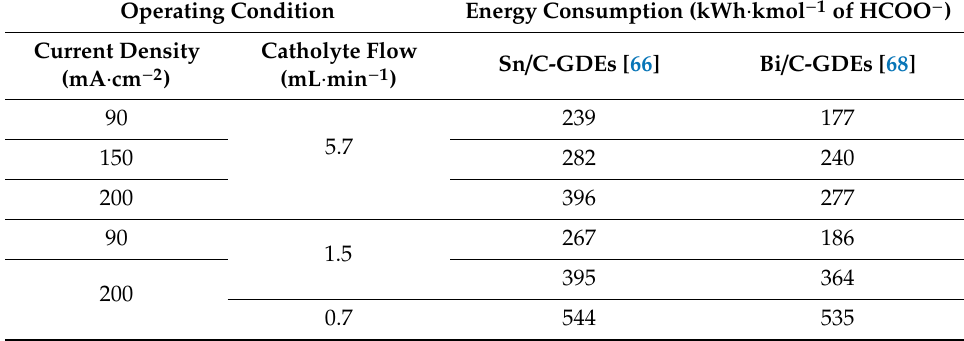
working with Sn / C-GDEs and Bi / C-GDEs at di ff erent operating conditions (current density and catholyte flow). Data taken from references